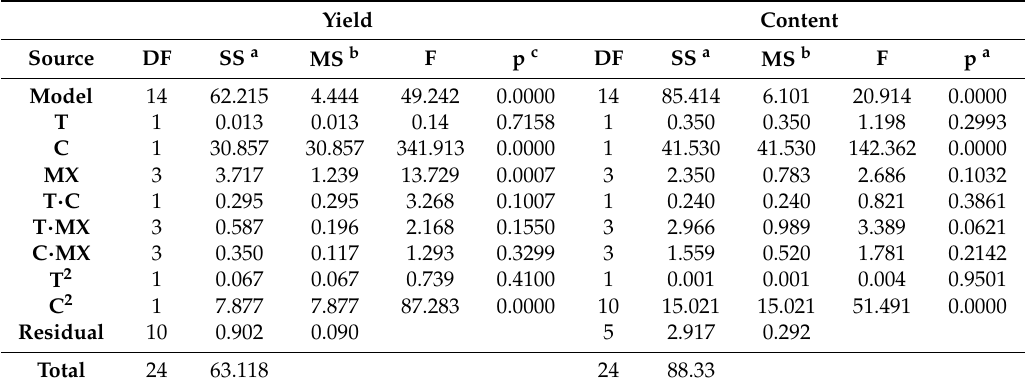
Table 2. ANOVA results determined for the yield and content of antioxidant in the BJ-MX. Yield Content Source